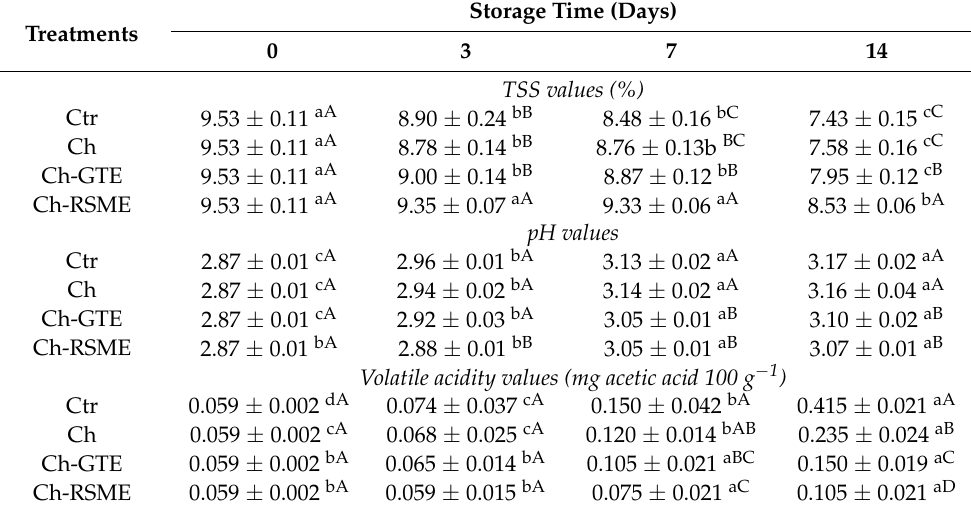
Storage Time (Days)